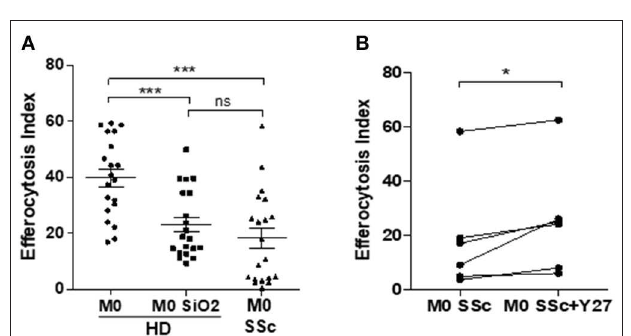
FIGURE 8 | RhoA/ROCK pathway inhibition by Y27632 enhances efferocytosis capacities of MDM from patients with systemic sclerosis. (A) EI of M0 MDM from healthy donors untreated or treated with 25 µ g/cm 2 of SiO 2 for 4h and of M0 MDM from SSc patients (Experiment on MDM from 20 different healthy donors and 20 different SSc patients). (B) EI of M0 MDM from SSc patients pre-treated or not with 20 µ M Y27632 before exposure to apoptotic Jurkat cells (apoJ) for 90min (Experiment on MDM from 6 different healthy donors). * p < 0.05; ** p < 0.01; *** p < 0.001; ns, not significant.